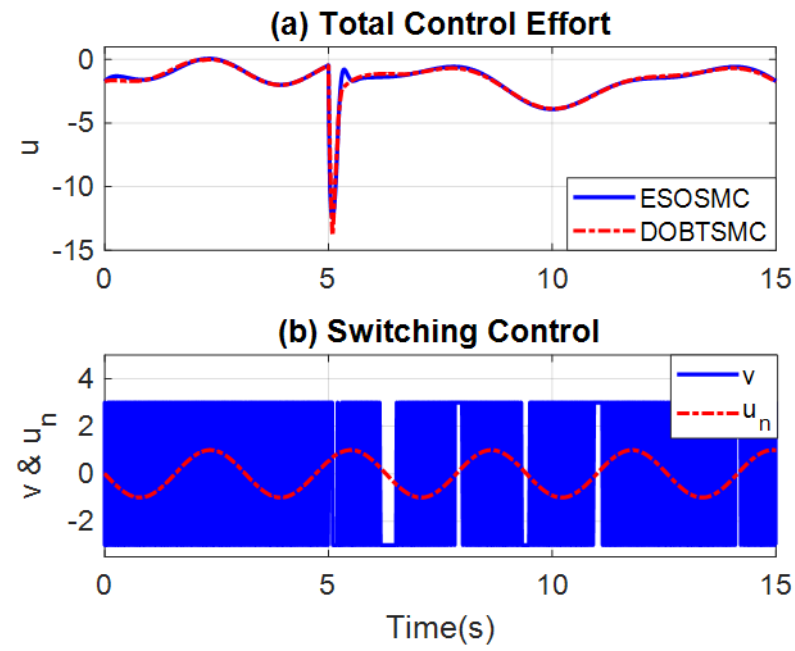
Figure 3. Total control signal ( a ) and switching control signal ( b ).